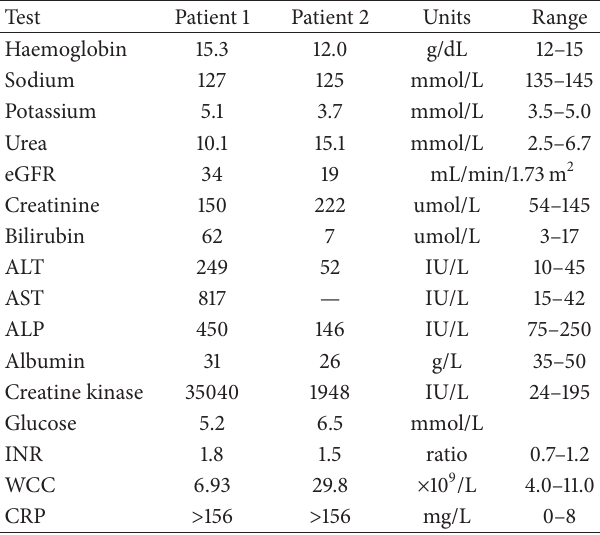
Table 1: Blood results from patients 1 and 2 taken upon admission to our hospital before plastic surgery referral.